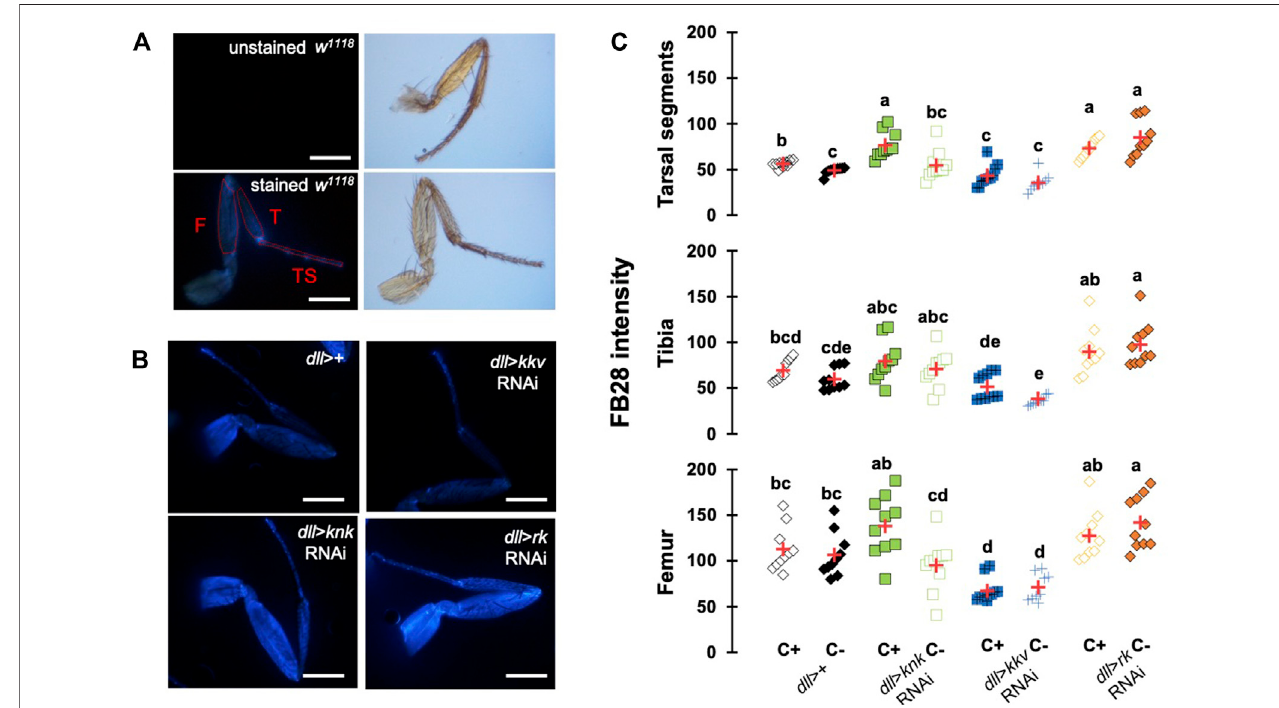
FIGURE 5 | FB28 hot staining combined with transgene differentially expressed in the legs reveal how speci fi c genes affect chitinous content. (A) Absence of auto fl uorescenceinunstained w1118 legs(upperpictures).FluorescenceisonlyseenafterFB28staining(lowerpanel).Picturesofthelegbybright fi eldareshownonthe right. Scale bars = 0.5 mm. (B) Female forelegs stained with FB28 (65 ° C during 60 min). Pictures were taken from fl ies prewashed with chloroform (C+) before staining. Distalless -GAL4 was used to speci fi cally drive RNAi expression in the Drosophila leg. dll -GAL4 is gradually expressed from the most distal part of the legs (tarsal segments)tothejunctionwiththethorax. Twochitin-relatedgenes knickkopf ( knk ) and chitinsynthase 1 ( kkv ) weredown-regulated.Additionally,the “ tanning-hormone ” receptor DLGR2 ( rk ) was down-regulated. Scale bars = 0.3 mm (C) FB28 intensity quanti fi cation. FB28 intensity in tarsal segments (TS), tibia (T) and femur (F) were measuredasillustratedbythered lines in (A) .Dataarerepresentedasscattergramsshowingall datapointswiththemean(red crosses). Differentmarkershapes/colors represent the different genotypes. Different letters indicate statistically signi fi cant differences (one way Kruskall-Wallis test followed by a Conover-Iman procedure, p -value < 0,0001). n = 10 in each